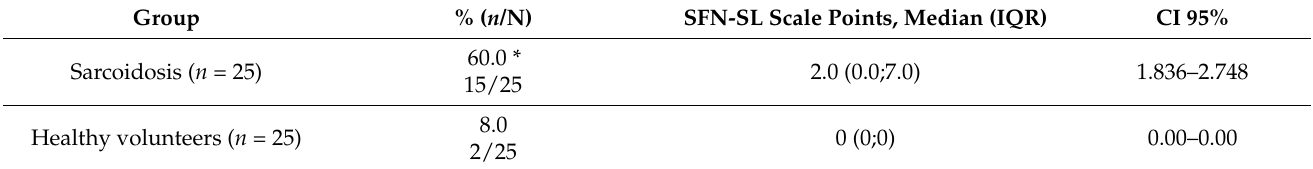
Table 1. The results of the “Small Fiber Neuropathy Screening list” (SFN-SL) testing in patients with pulmonary sarcoidosis and healthy